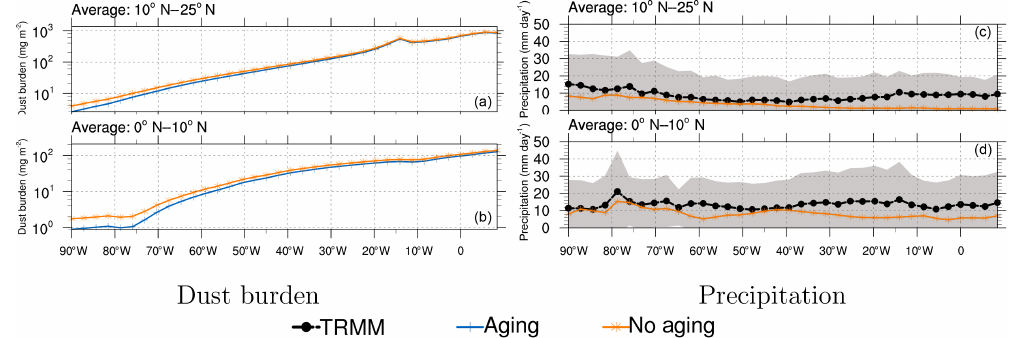
Figure 15. The (left) dust burden and (right) precipitation for different regions: (top) dust transport over the Atlantic Ocean zone and (bottom) the dust–ITCZ zone from 0 to 10 ◦ N. The shaded area represents 1 standard deviation of TRMM precipitation. The results show the long-term average of the entire evaluation period from 2000 to